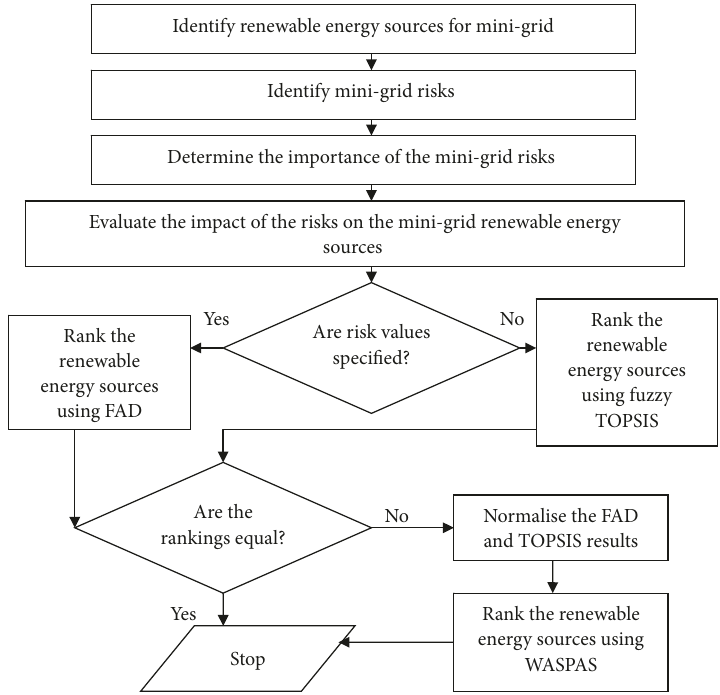
Figure 1: Proposed framework for mini-grid energy source